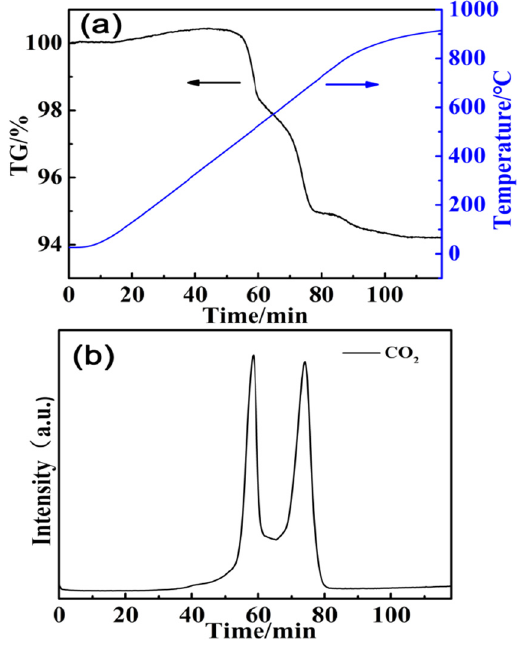
Figure 2: Thermogravimetric analysis of the REE - containing tailings: ( a ) thermogravimetric analysis and ( b ) CO 2 mass spectrum signal.